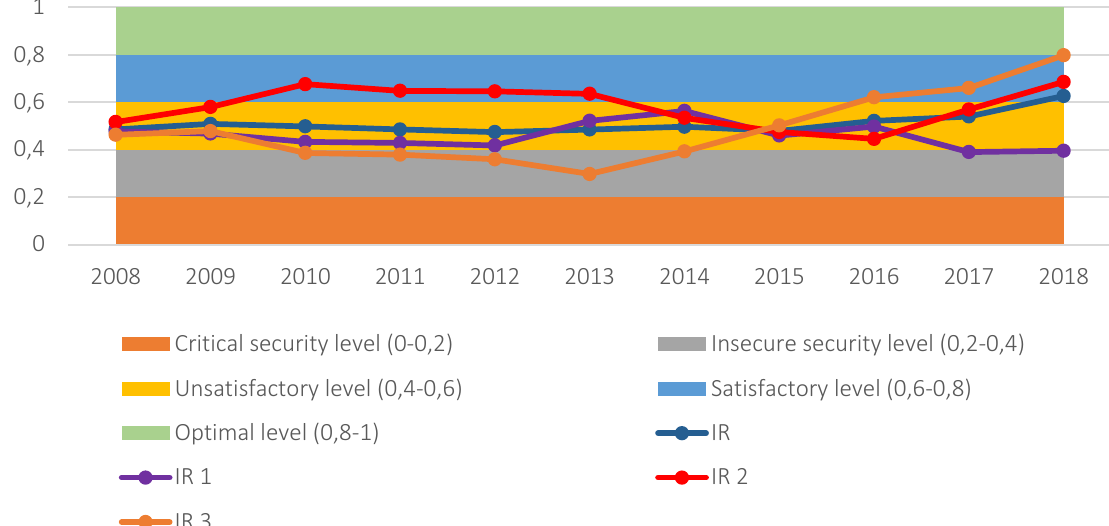
Figure 1. Dynamics of indicators by components (IR1-IR3) and an integrated indicator of Ukrainian banking sector’s financial security (IR) in